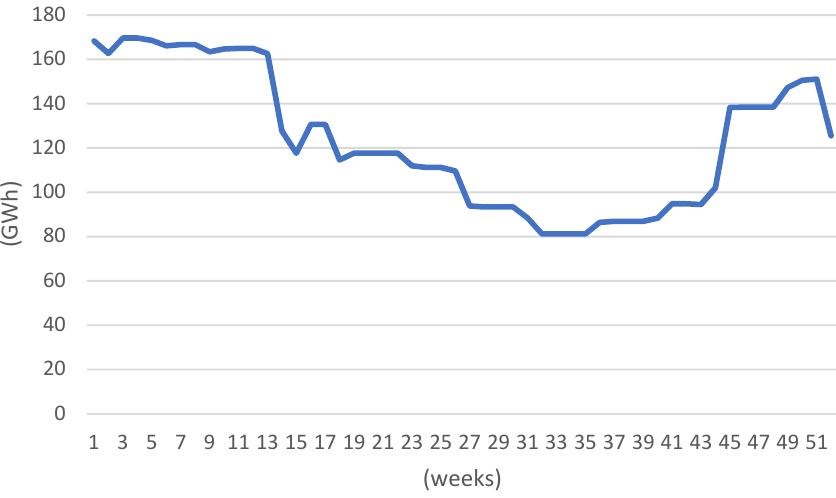
Figure 12. Average weekly production of the Croatian hydro sector.